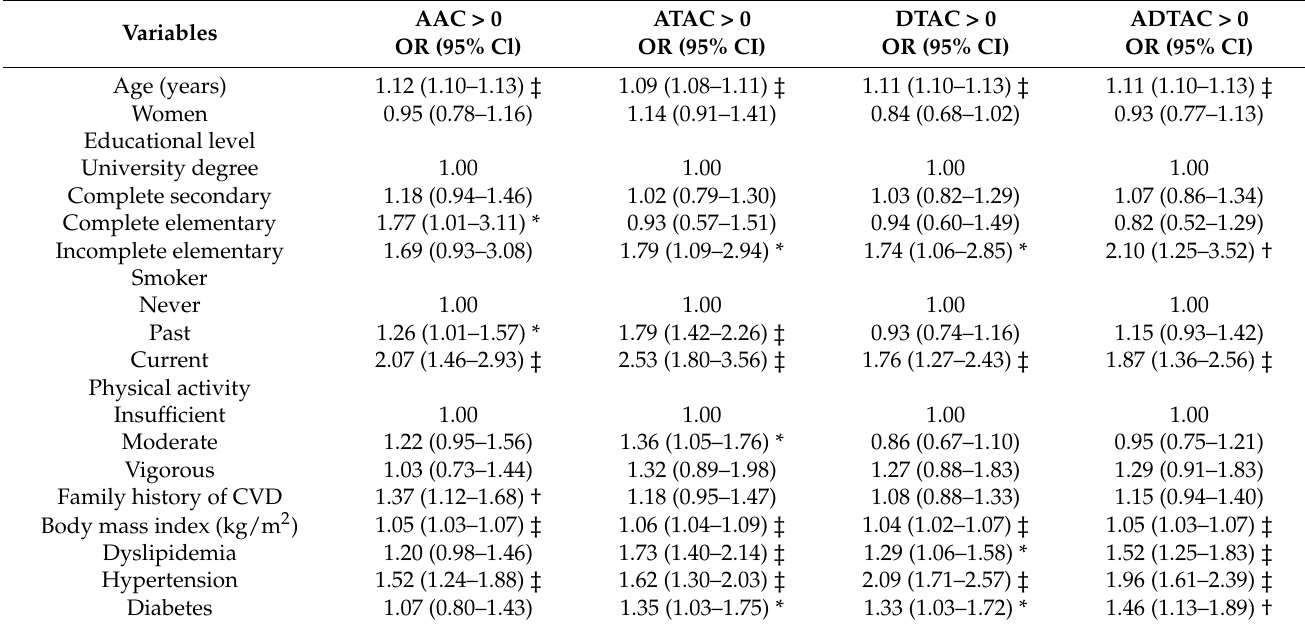
Table 2. Cardiovascular risk factors associated with the presence of calcium in the aortic arch, ascending aorta, descending thoracic aorta and in combination of calcium in the ascending and descending thoracic aortic segments in the final multivariable analysis. ELSA-Brasil,